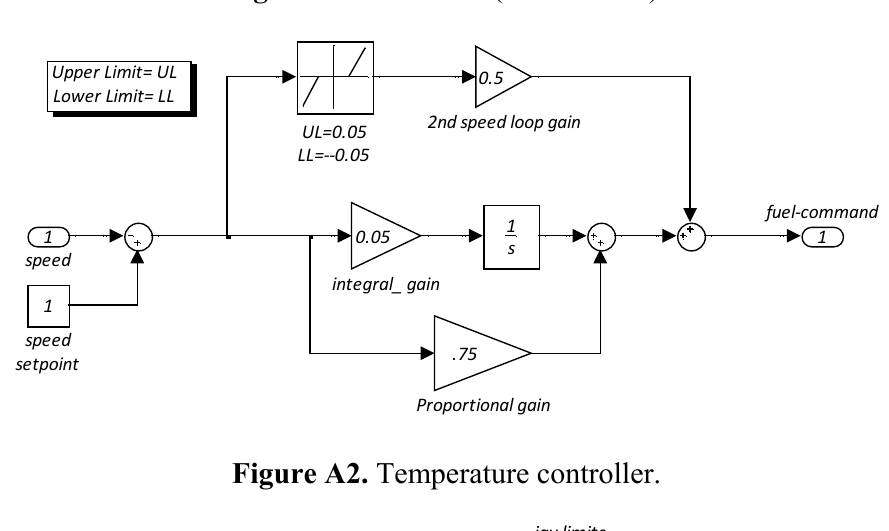
Figure A2. Temperature